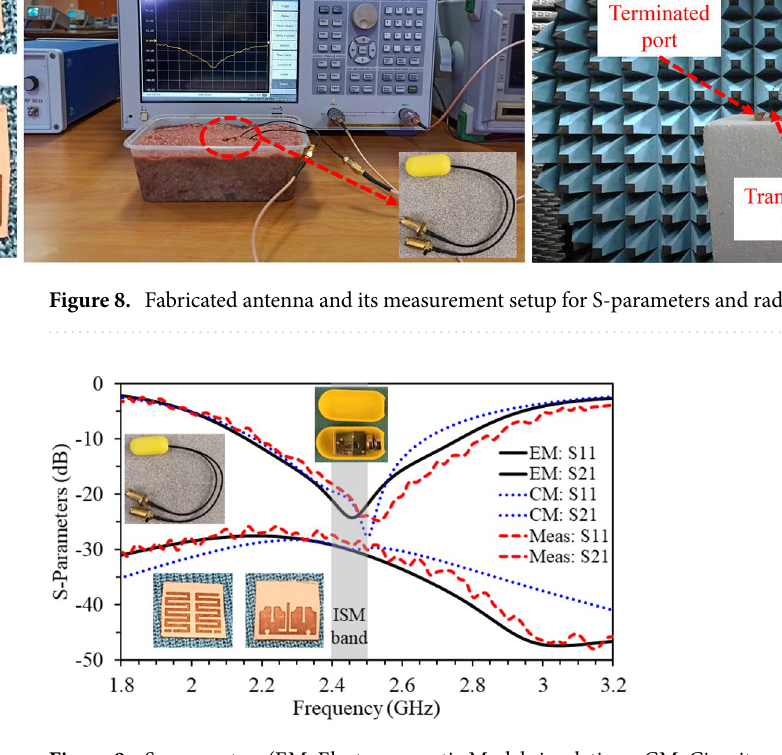
Figure 9. S-parameters (EM: Electromagnetic Model simulations; CM: Circuit model simulations; Meas: